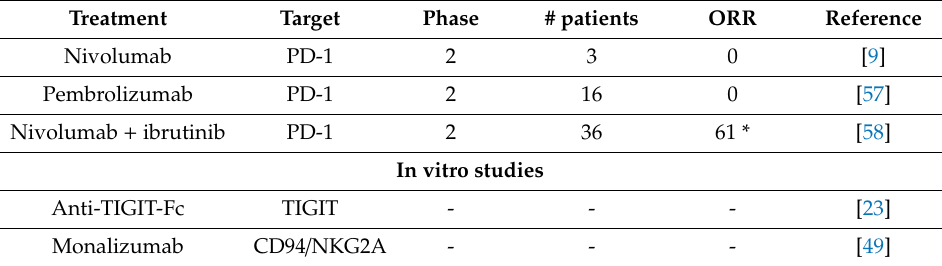
Table 2. Overview of immune checkpoint inhibitors tested in